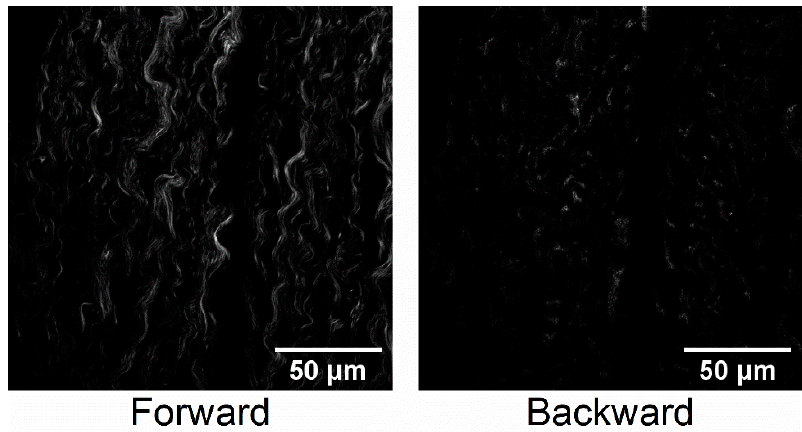
Figure 1. Corresponding Second Harmonic Generation (SHG) forward- and backward-collected images of a high-grade cancer in the fallopian tube, showing different image features.